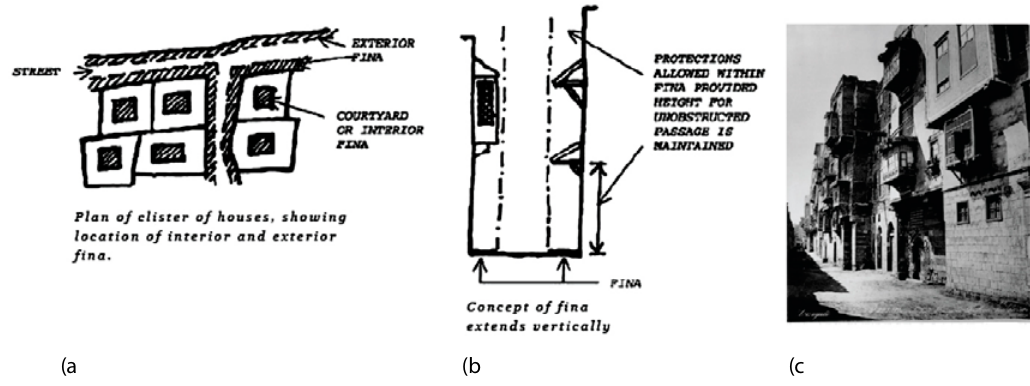
fig. 1a, b, c: The fina’ (Source: a: Hakim, 2010 and b: university of Chicago library. available on site: http://www.lib.uchicago.edu/e/su/mideast/photo/CairoStreet.html, first accessed on